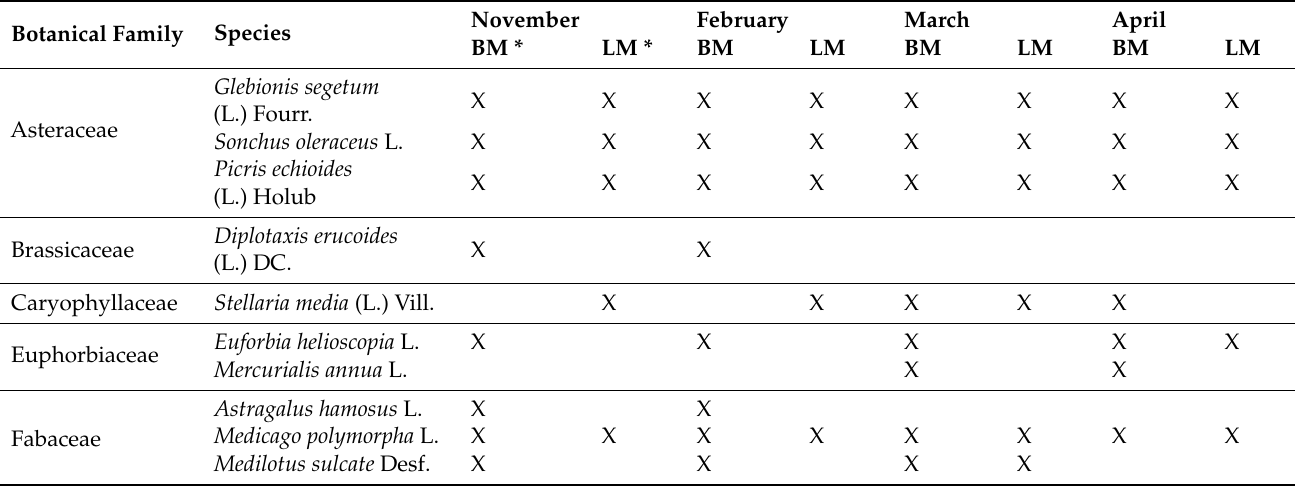
Table 2. Weed species recorded in mulched plots between November 2019 and April